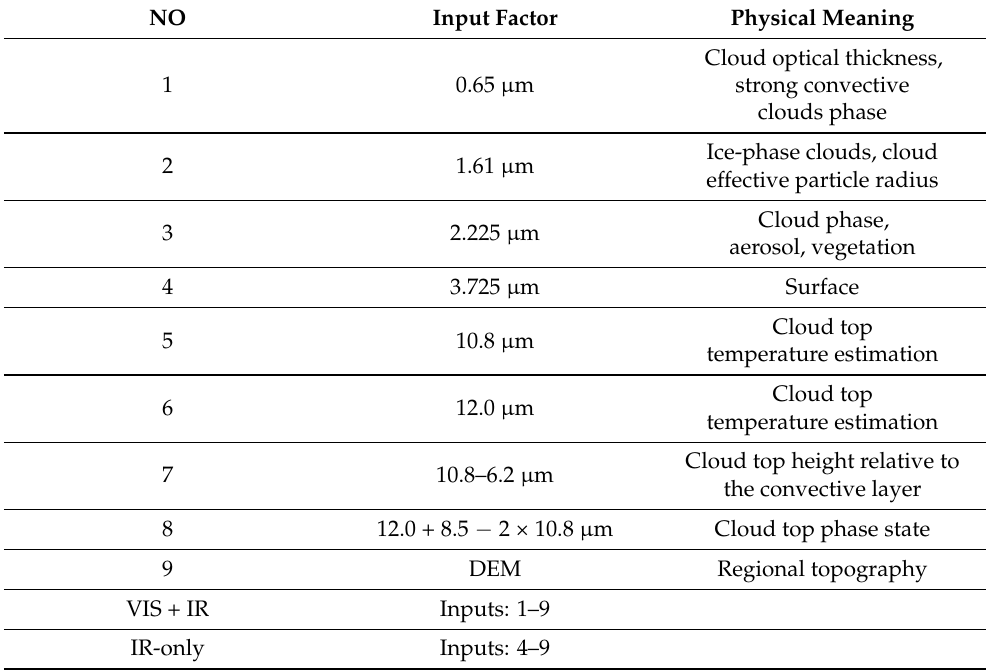
Table 1. Satellite characteristic parameters and physical significance of model